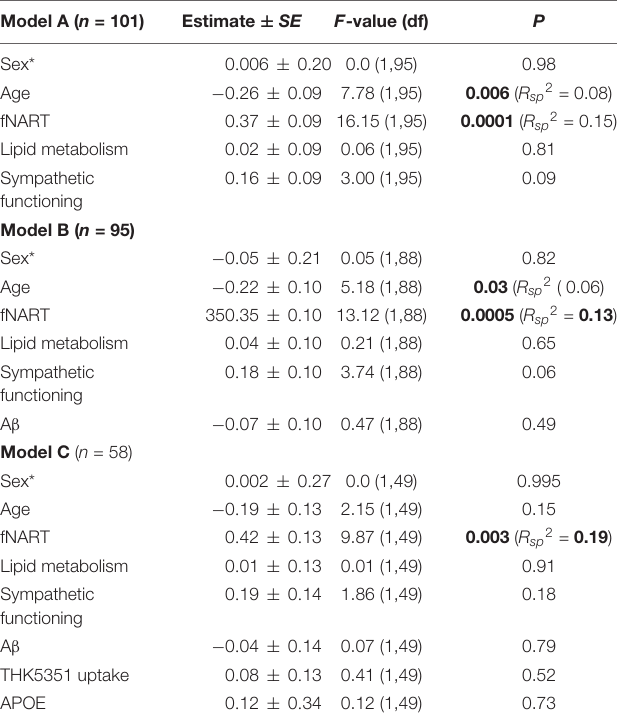
TABLE 5 | Statistical outcome of GLMM examining associations between attentional functioning (dependent variable) and: (A) scores of cognitive reserve and allostatic load ( n = 101); (B) scores of cognitive reserve and allostatic load, and A β ( n = 95); (C) scores of cognitive reserve and allostatic load, A β , tau, and APOE ( n =